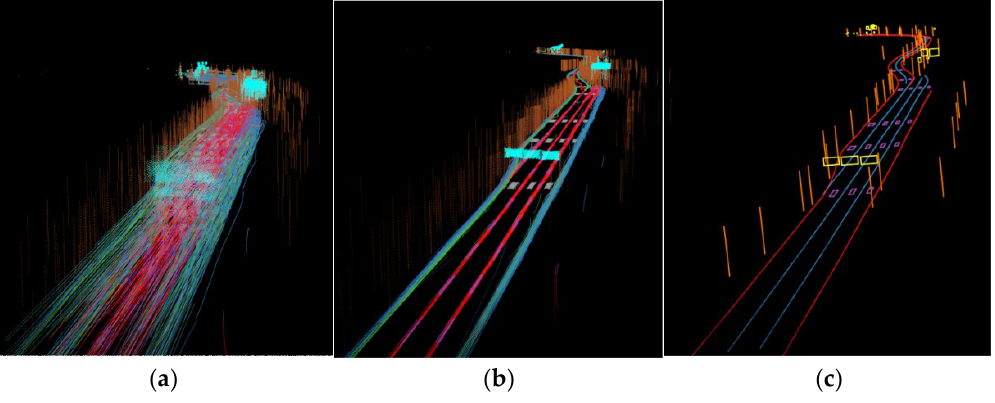
Figure 10. Effect of fusion mapping on-cloud process. ( a ) The original fragment map with multiple LSMs unified to the global coordinate system; ( b ) multiple fragment maps via GBA_SGICP algorithm optimization and semantic location adjustment; and ( c ) fragment map after aggregation and vectorization of semantic elements.